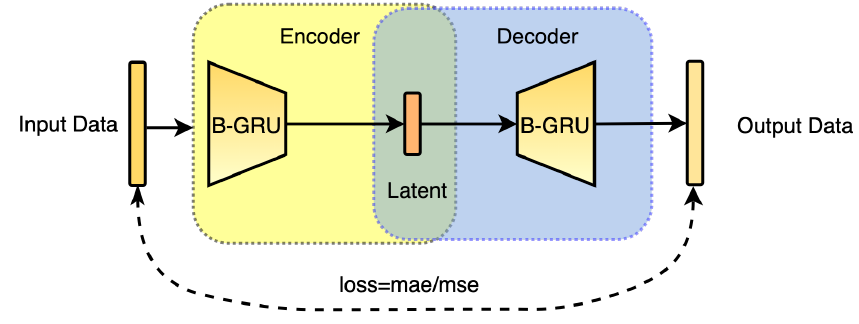
Figure 3. Bi-GRUs